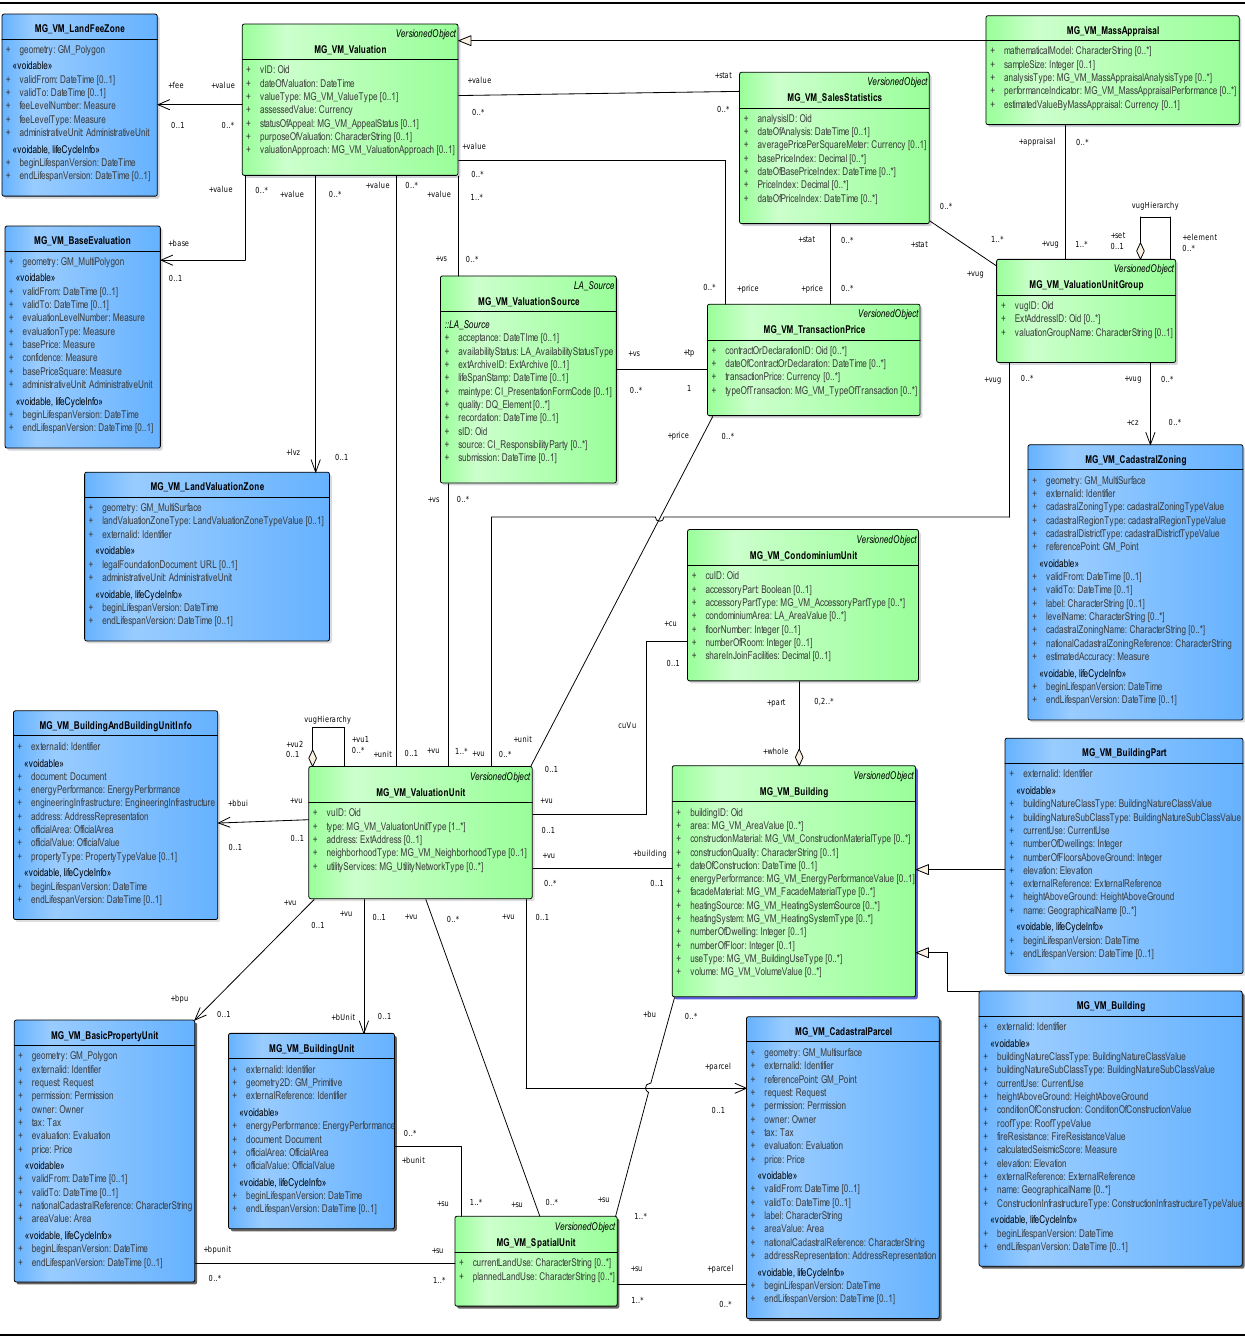
Figure 8. Mongolian LADM Valuation Information Model Country Profile (with basic valuation classes in green and newly added/extended classes in blue).